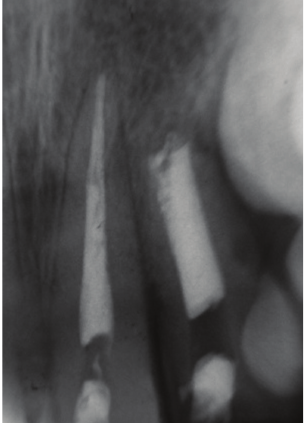
Figure 5: Periapical radiograph: root canal treatment finished in tooth 22 and tooth 21 in good condition after 1 year (seventh session; March